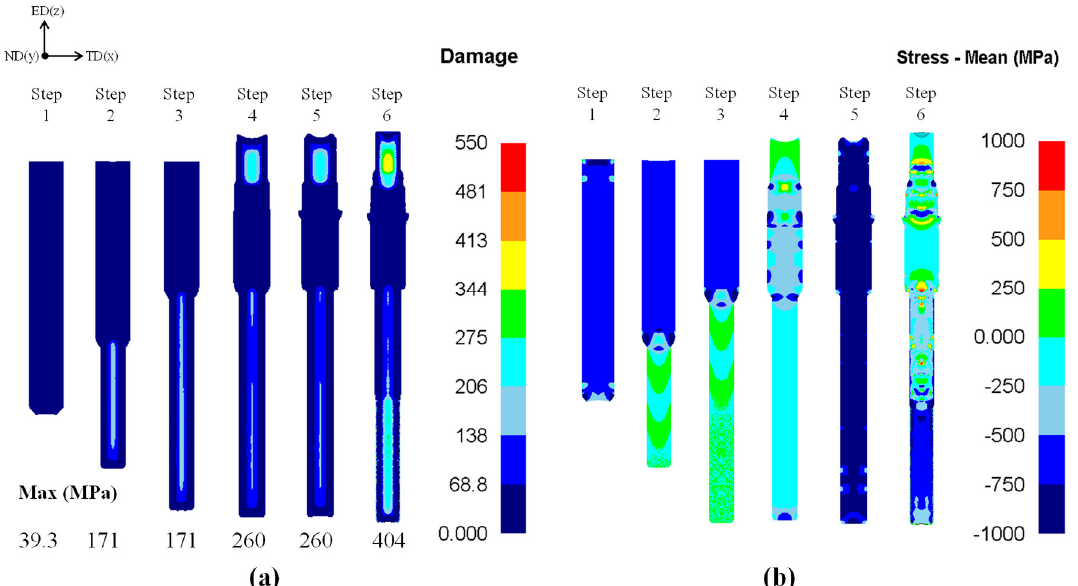
Figure 5. Numerical results of ( a ) ductile fracture prediction and ( b ) hydrostatic stress (mean stress).